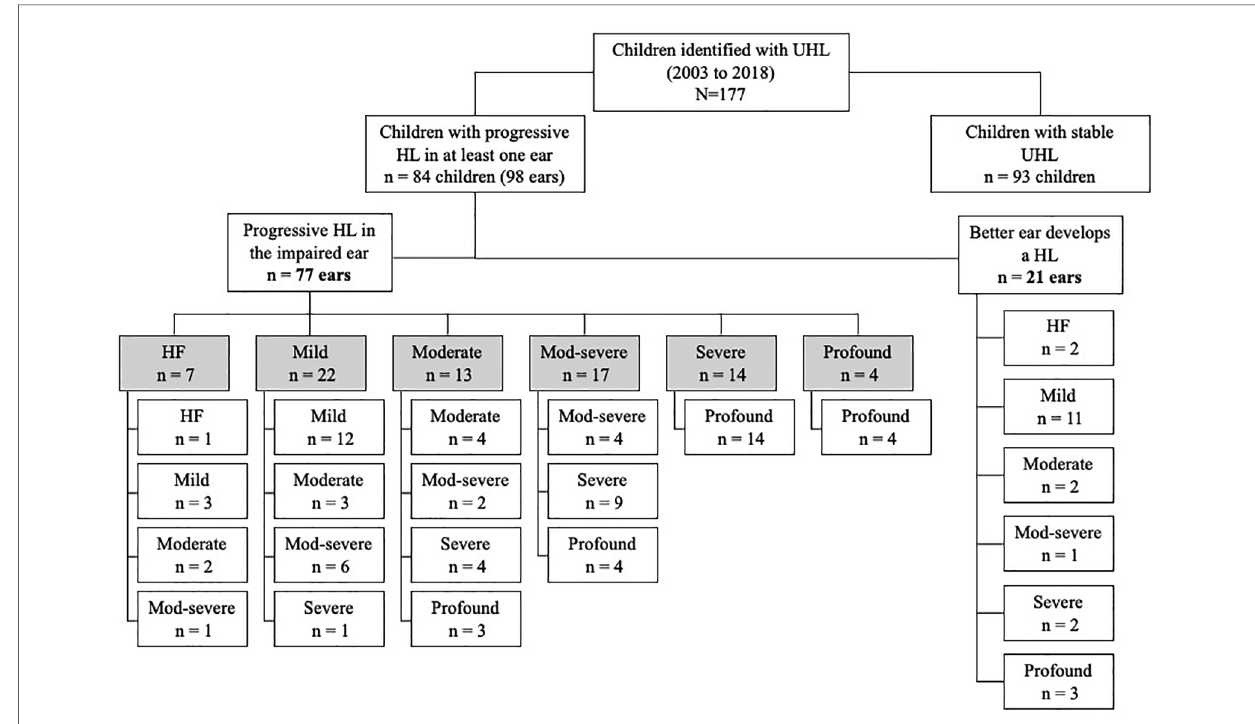
FIGURE 3 Category of hearing loss severity at diagnosis and at most recent assessment. The shaded boxes represent the degree of hearing loss in the impaired ear at diagnosis and the unshaded boxes the degree at fi nal assessment. For the 21 ears that developed hearing loss (previously normal hearing), degree of hearing loss at fi nal assessment is shown. UHL, unilateral hearing loss; HL, hearing loss.